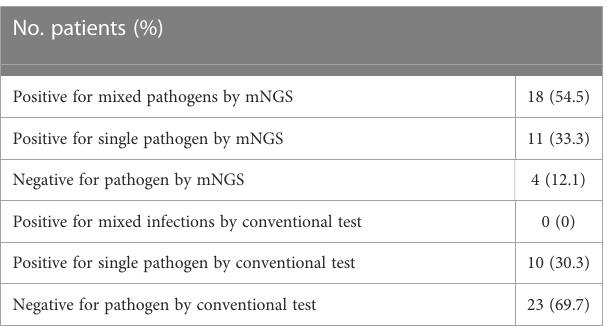
TABLE 6 Results obtained in the detection of single and mixed pathogens